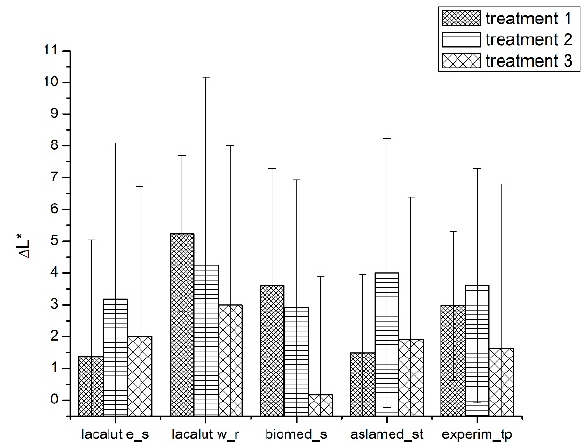
Figure 3. Average values and standard deviations of Δ L* during experimental phases.